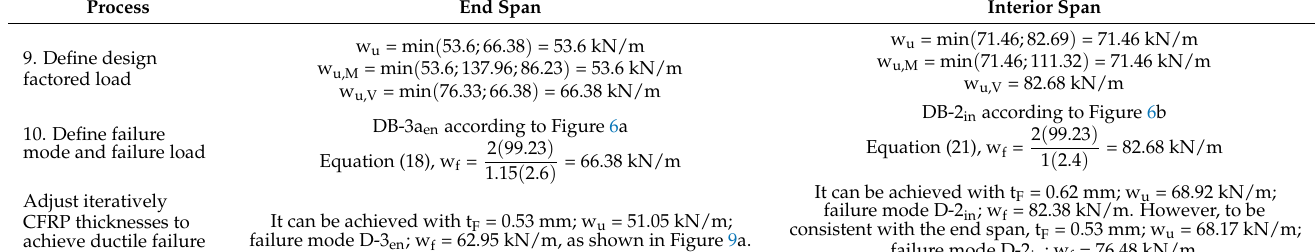
Figure 8. Predicting failure limits and failure mode for the retrofitted slab: ( a ) the end span; ( b ) the interior span.